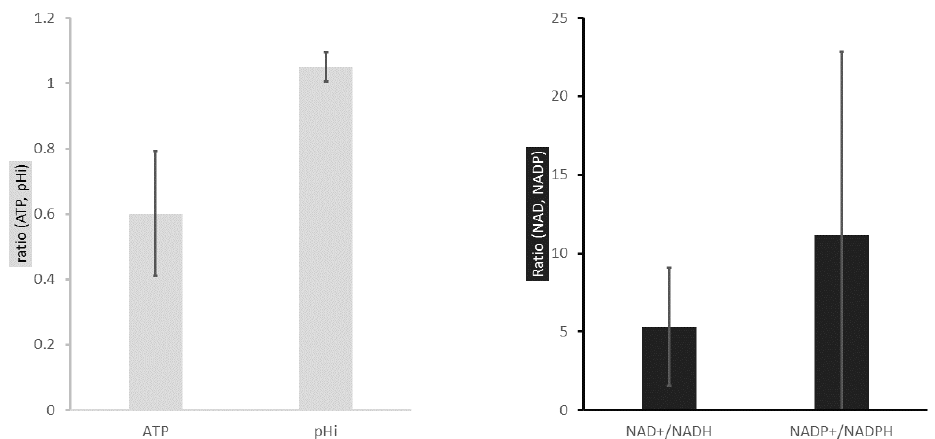
Figure 2. Comparison of the energetic status of normal and cancer cells. These histograms represent the average of ATP, pHi, NAD + /NADH, NADP + /NADPH cancer/normal ratios over the cell cycle. Raw data for all experiments are reported in the supplementary materials section. ( A ) In normal cells, the average ATP concentration over the cell cycle is higher compared to the cancer cell population (ratio = 0.60 ± 0.19). The intracellular pH (pHi) of cancer cells is slightly higher than normal cells (ratio = 1.05 ± 0.04); and ( B ) the redox ratios (NAD + /NADH and NADP + /NADPH) are five and ten time higher in cancer cells compared to the normal cell population (5.31 ± 3.76 and 11.15 ± 11.71,